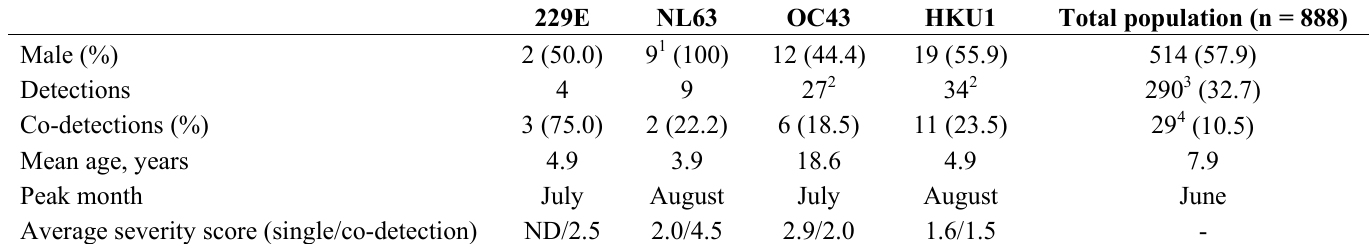
Table 2. Patient population and HCoV findings.